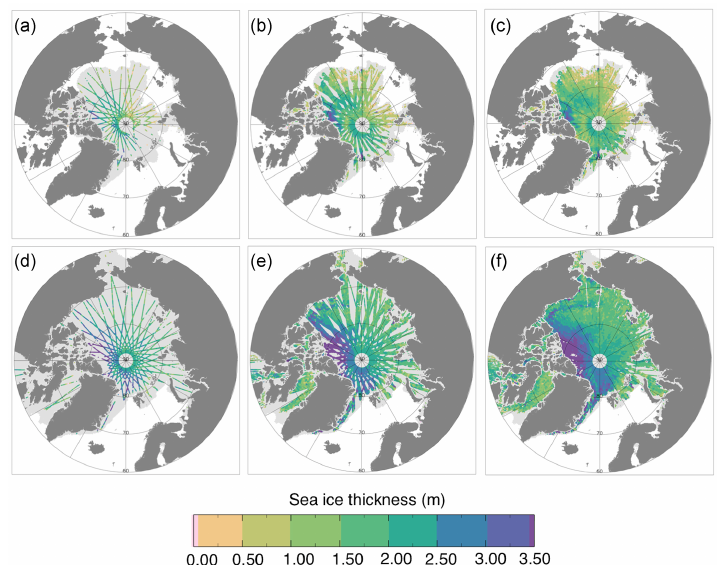
Figure 1. Near-real-time (NRT) Arctic sea-ice-thickness estimates from CryoSat-2. (a–c) Thickness estimates for the final 2, 14 and 28 days of October 2014 respectively. (d–f) Thickness estimates for the final 2, 14 and 28 days of March 2015 respectively. NRT sea-ice-thickness data are output Arctic-wide on a 5km square grid. All thickness measurements within a 25km radius of the centre of the grid are averaged, with all points receiving equal weight. The sea ice extent mask is shaded in light grey and highlights unmapped areas of the sea